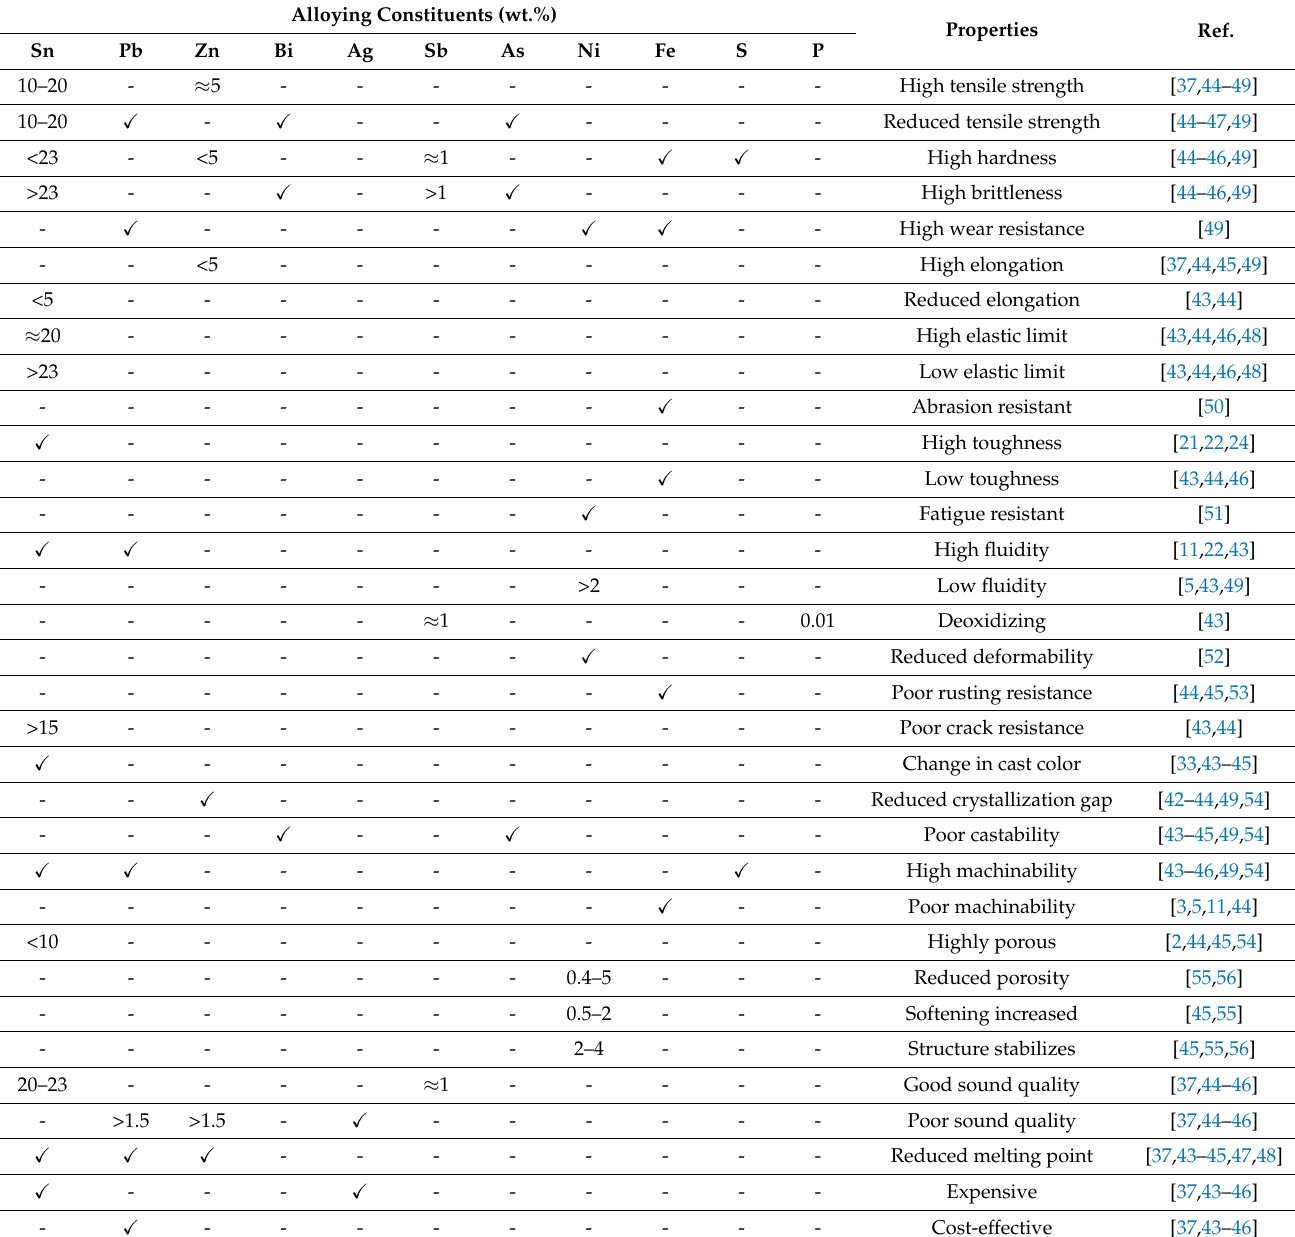
Table 3. Composition of bronze cast bells (Eastern and Western bells) and their possible effects on the mechanical properties. The tick mark ( (cid:88) ) indicates the presence of particular element in the casting. Alloying Constituents